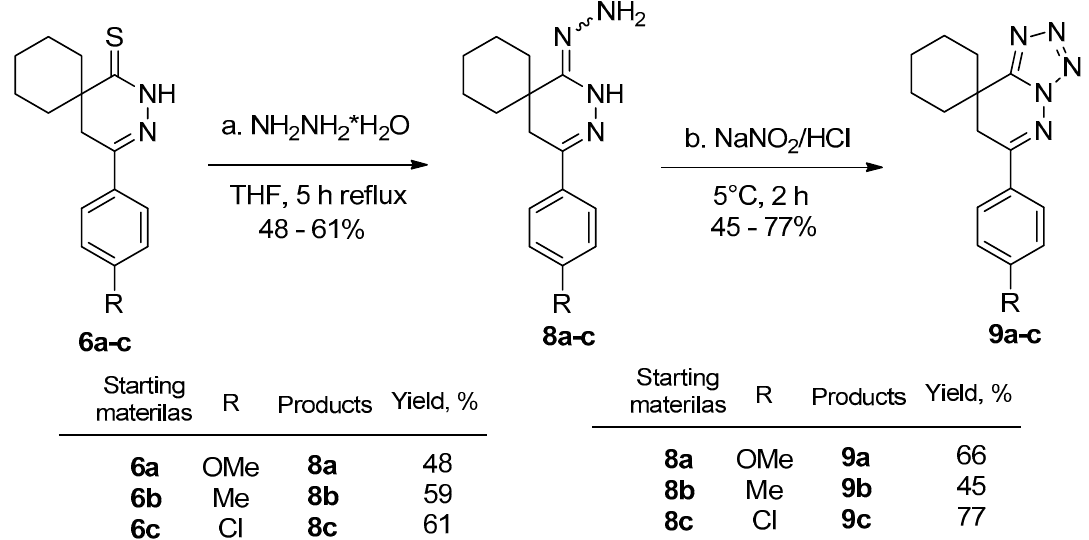
Scheme 4. Synthesis of the hydrazono-pyridazinone ( 8a–c ) and tetrazole derivatives ( 9a–c ) (a) 6a–c (0.40 mmol), hydrazine monohydrate (1.20 mmol), tetrahydrofuran (THF), reflux, (5 h); (b) 8a–c (0.34 mmol), NaNO 2 (0.51 mmol), 0.5 N HCl, 5 ◦ C,